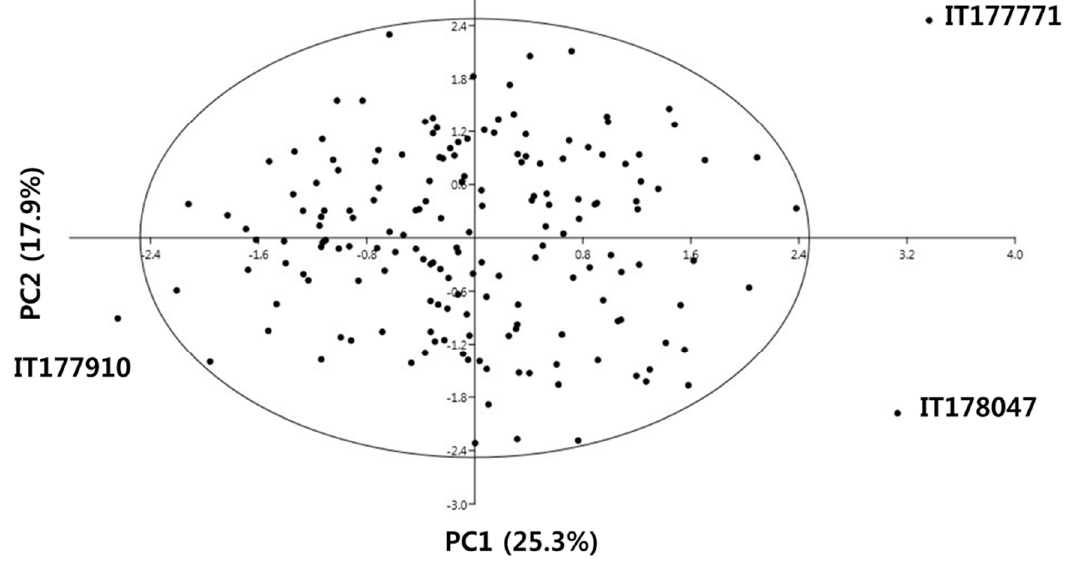
Figure 2. 2D scatter diagram of principal component analysis (PCA) of 172 KBSLs based on agricultural traits, phytochemicals, and antioxidant activities.